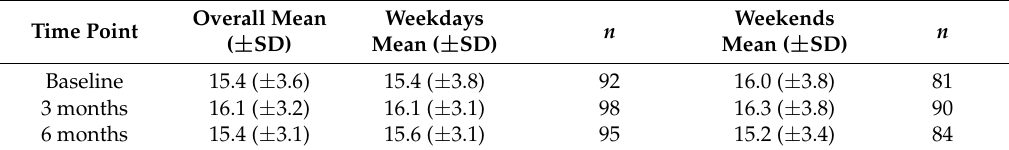
Table 2. Average wear time in hours for both weekdays and weekends at each time point.